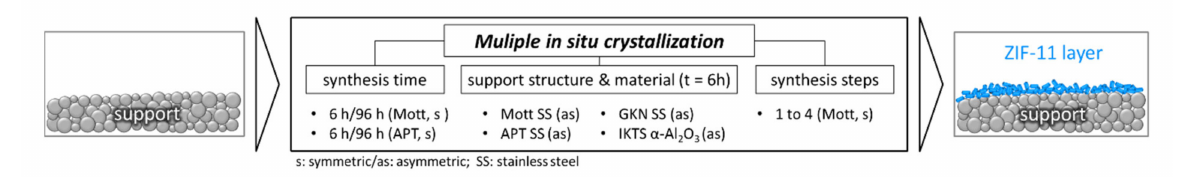
Figure 4. Overview on variations performed within multiple in situ crystallization of ZIF-11 layers.